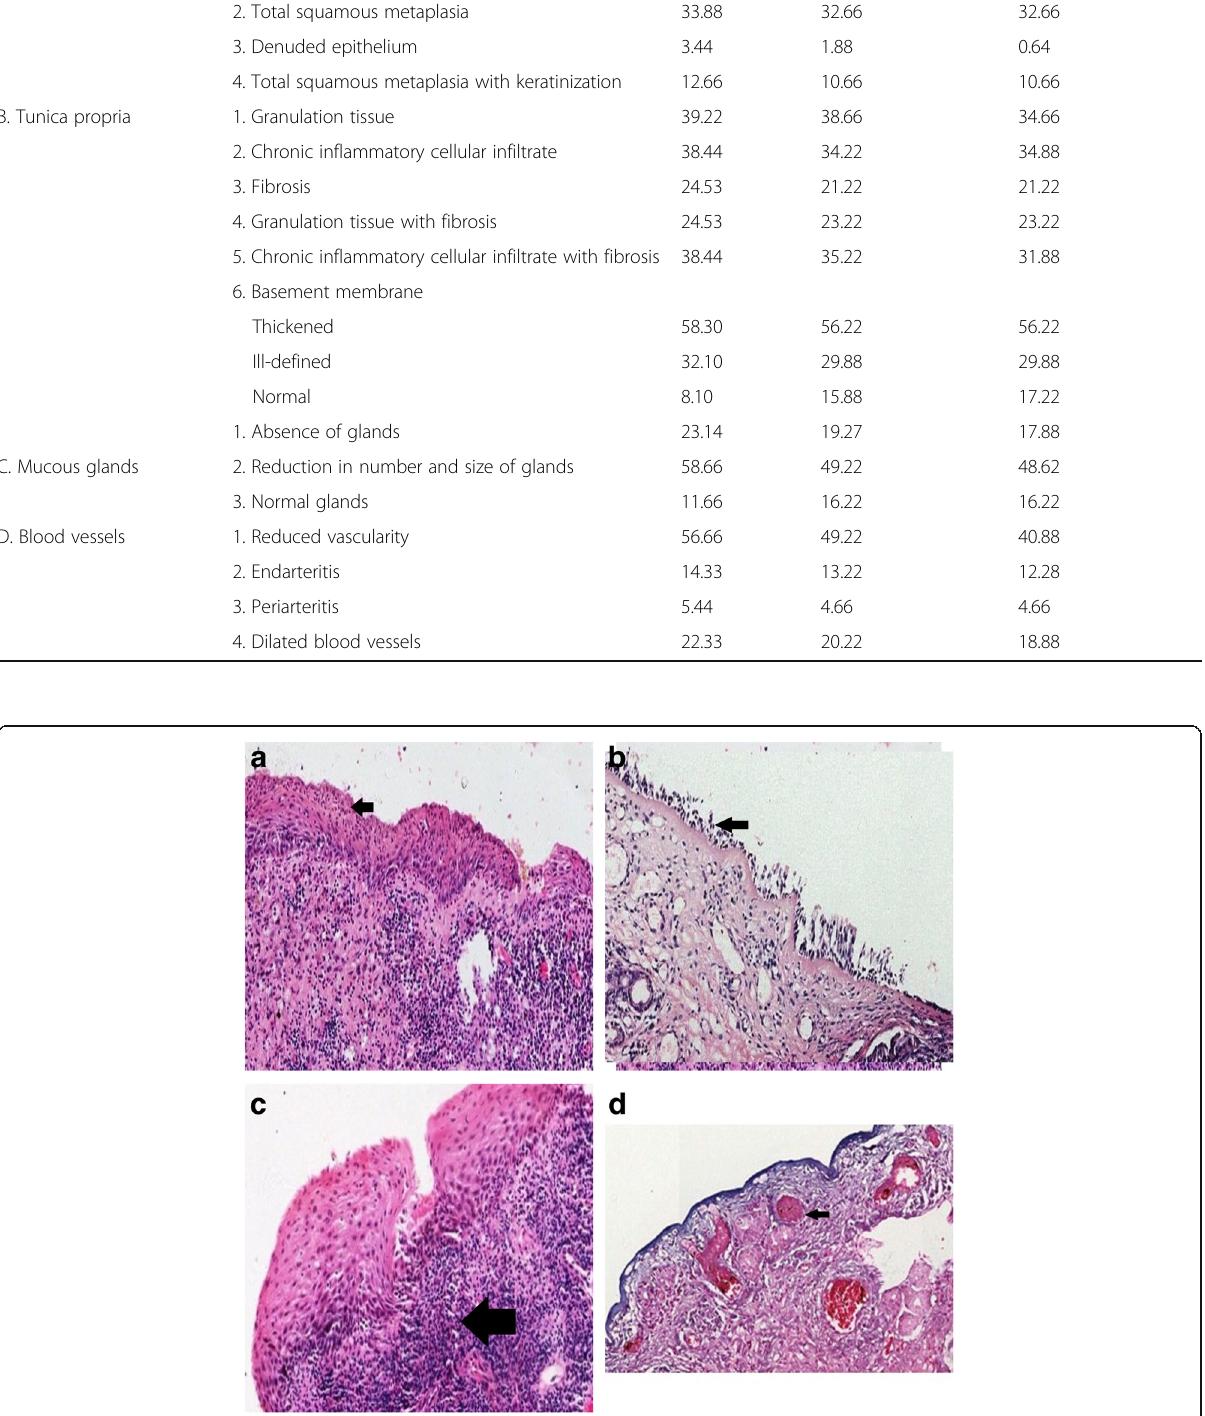
Fig. 3 a Squamous cell metaplasia (arrow); H&E, original, magnification × 200. b Erosion of the respiratory epithelium with cilia and goblet cell loss (arrow); H&E, original, magnification × 200. c Granulation tissue with abundant inflammatory cells (arrow); H&E, original, magnification × 200. d Stromal fibrosis, thick-walled vascular structures with abundant hemorrhage, and end arteritis obliterans (arrow); H&E, original, magnification ×